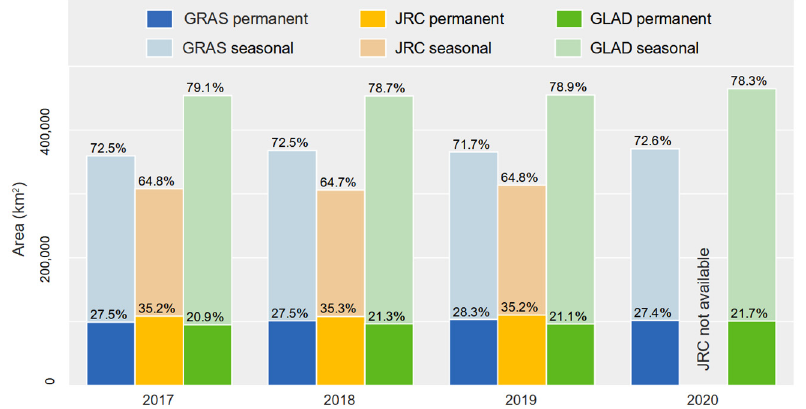
Figure 7. Permanent and seasonal waters as proportions of the total annual maximum water ex- tent (i.e., permanent + seasonal water).